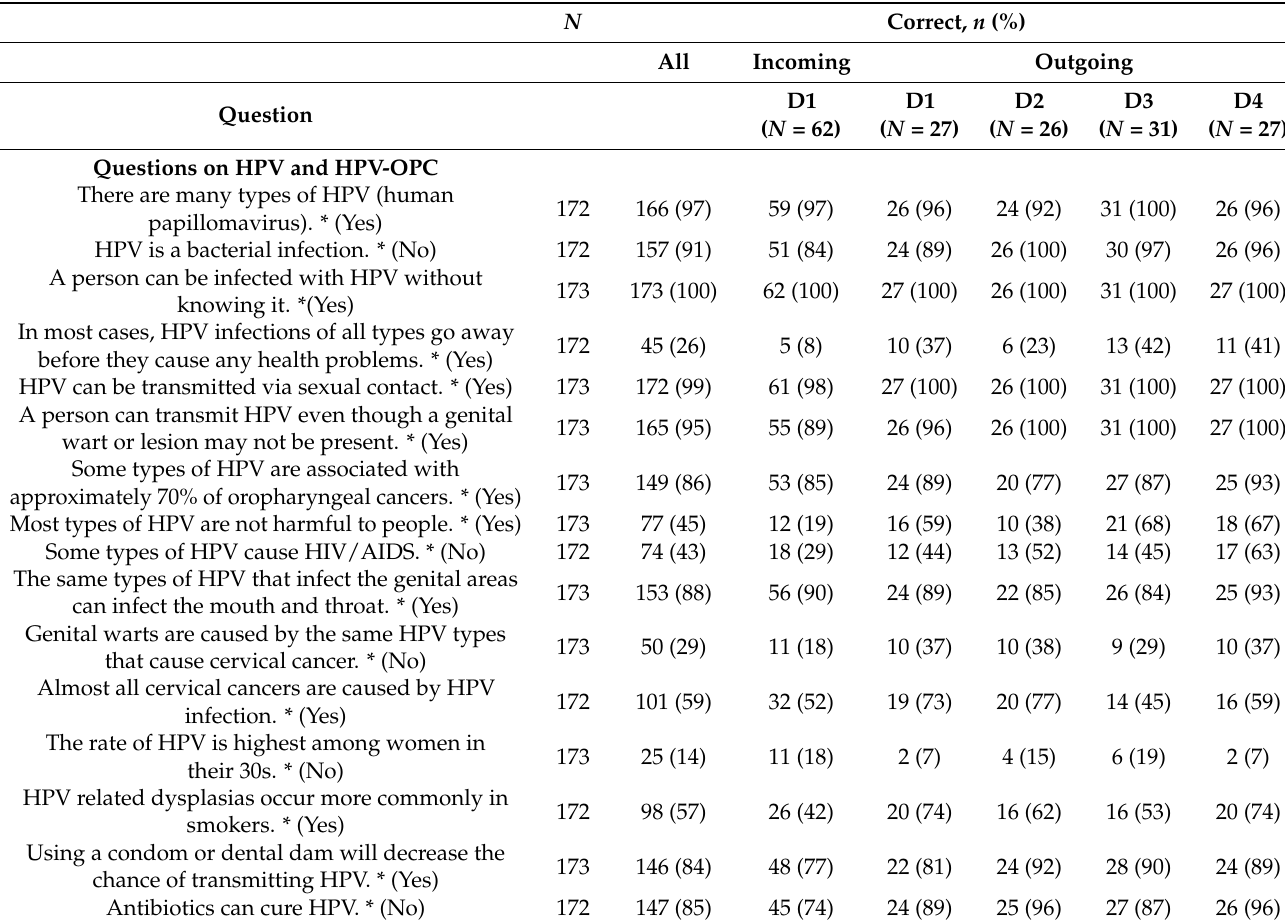
Table 2. 30-Item knowledge assessment of HPV and HPV-OPC and HPV Vaccine (electronic pre-survey).